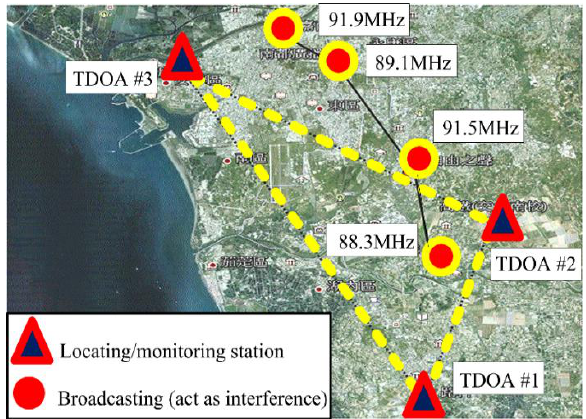
Figure 7. The proposed experiment configuration for investigating the TDOA limitation of location performance in multi-path effect of metropolitan area.